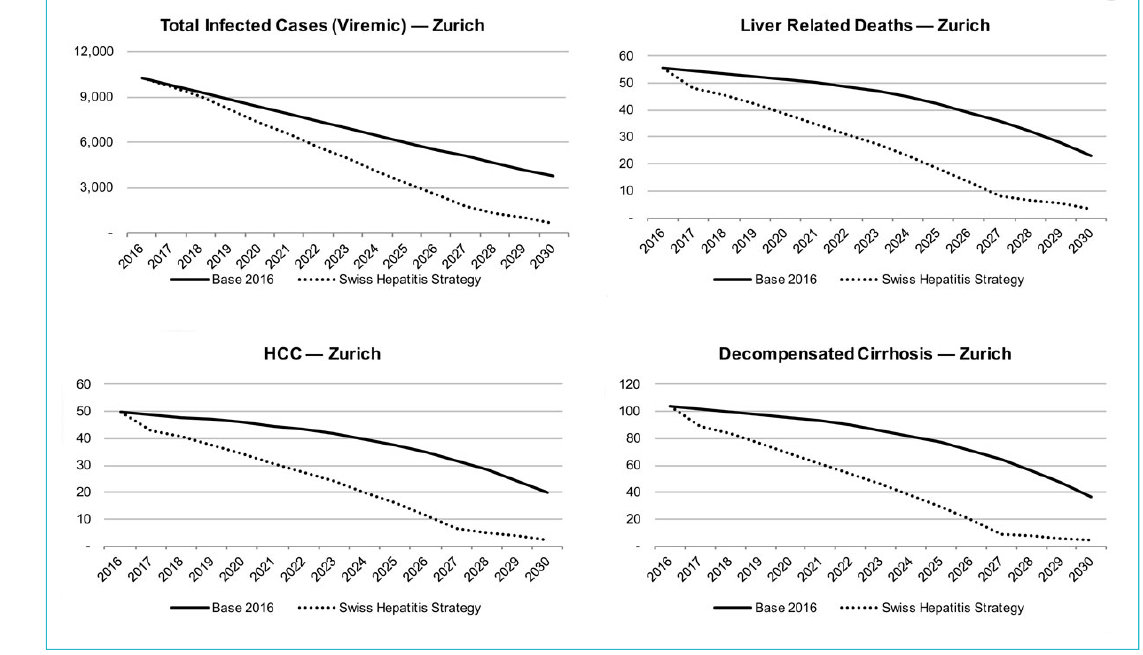
Figure 15: Total viraemic infections, liver related morbidity and mortality by scenario for the canton of